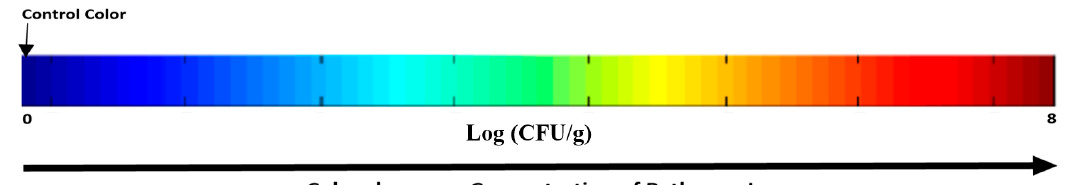
Figure 7. Map prediction for different samples with increasing number of E. coli from left to right, the blue is the control sample, and the left color is the target color expected. blue is the control sample, and the left color is the target color expected.